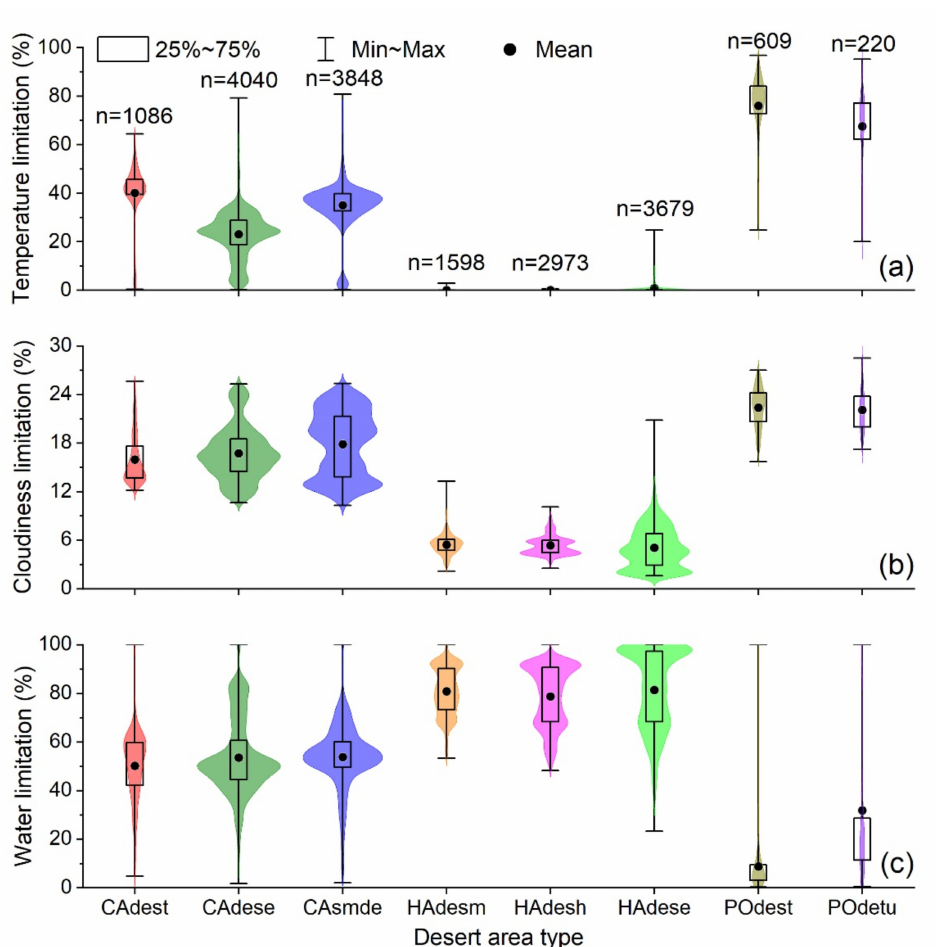
Figure 8. The relative importance of climatic limitation on vegetation dynamics in different desert areas over the Silk Road Economic Belt between 1982 and 2015. CAdest—cold arid desert steppe, CAdese—cold arid desert, CAsmde—cold arid semi-desert, HAdesm—hot arid desert semi-desert, HAdesh—hot arid desert shrub, HAdese—hot arid desert, POdest—polar desert steppe, POdetu— polar desert tundra. n—the number of all pixels in different desert areas. ( a – c ) indicate the limitation of vegetation dynamics by temperature, cloudiness, and water,